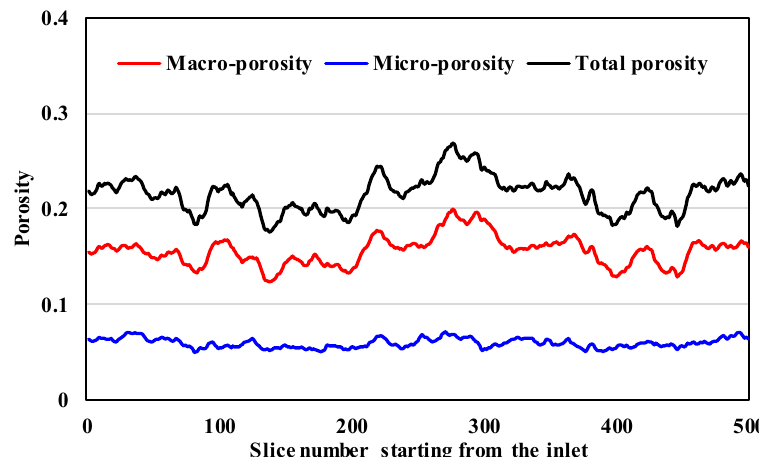
Figure 7. Oil saturation distribution of different stages.